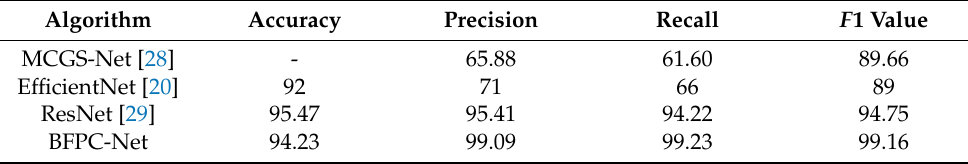
Figure 9. BFPC-Net training set and validation set accuracy. Table 3. Comparison of different algorithms (%).